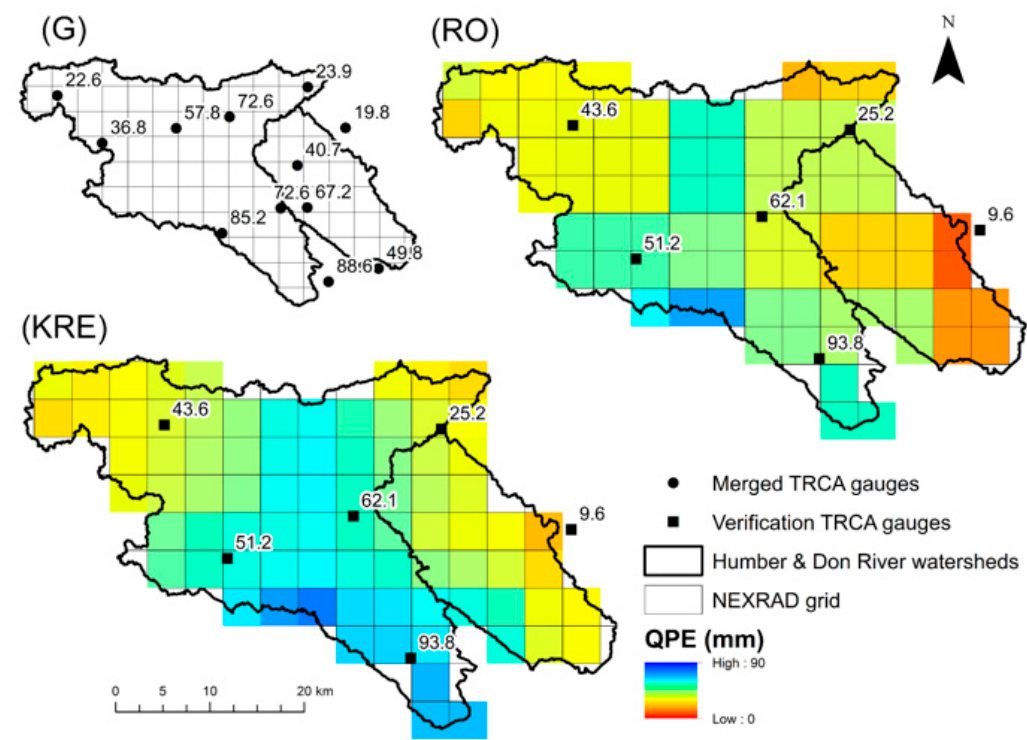
Figure 7. Comparison between the gauge (G), NEXRAD radar only QPEs (RO), and KRE merged QPE (KRE) precipitation field for event 3 (8 July 2013 1800 UTC to 9 July 2013 0200 UTC). The numbers represent observed precipitations at each gauge station in mm.